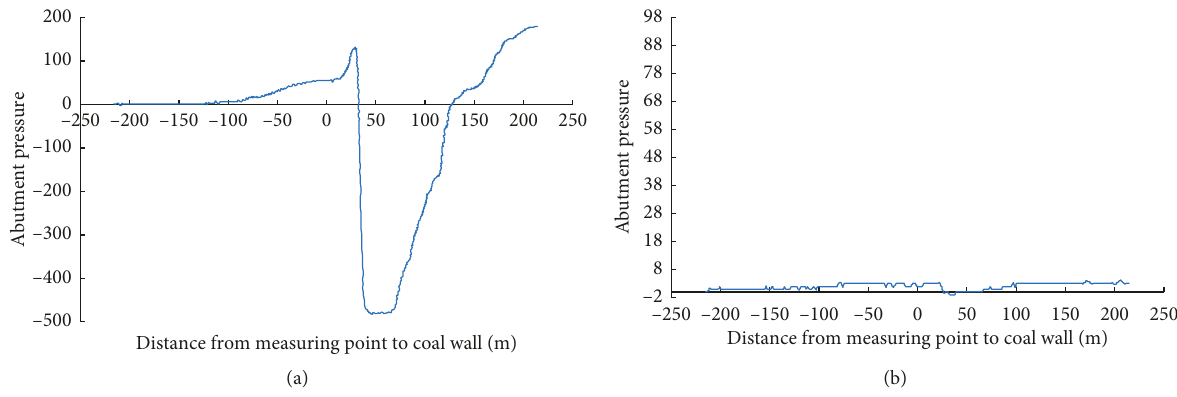
Figure 15: The changing curve of the abutment pressure in the roof as the advancement of working face at the floor strata 240 m away from the open cut (in the synclinal axis). (a) Roof (located at pressure cell 17). (b) Floor (located at pressure cell